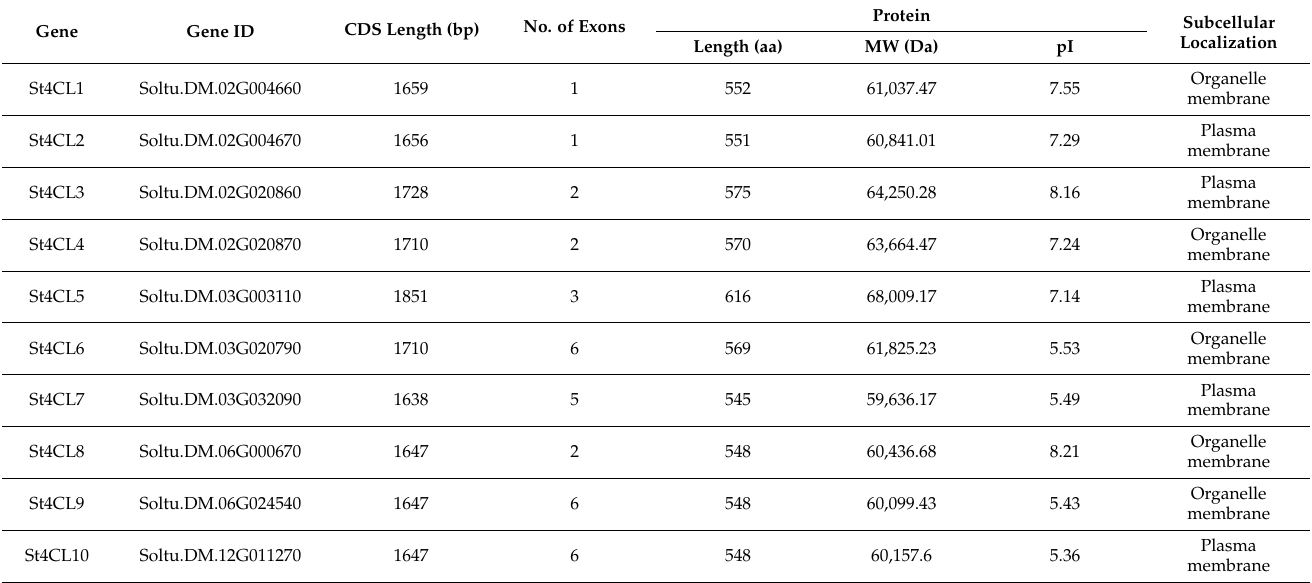
Table 1. 10 potato 4CL family genes were identified and protein properties